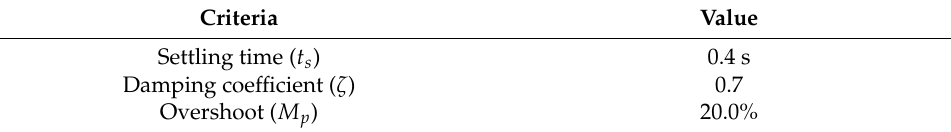
Table 5. Performance criteria for the speed loop